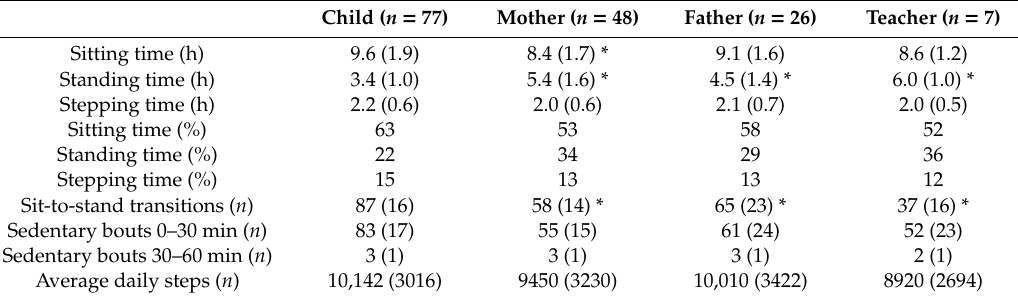
Table 2. Total daily physical activity and sedentary